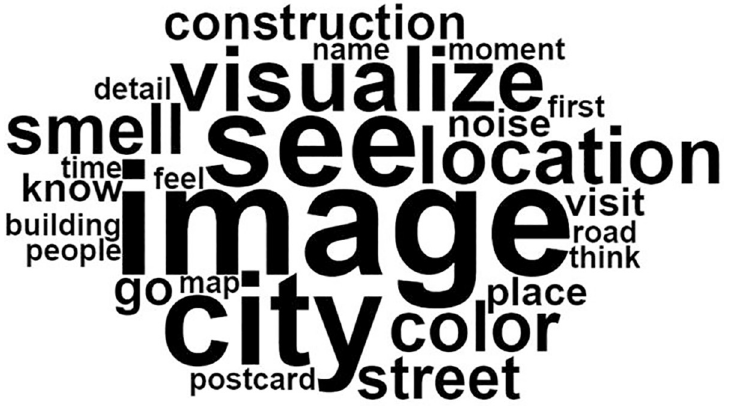
Fig 3. Word cloud for the autistic group (the original French word cloud is available in supplementary data) .